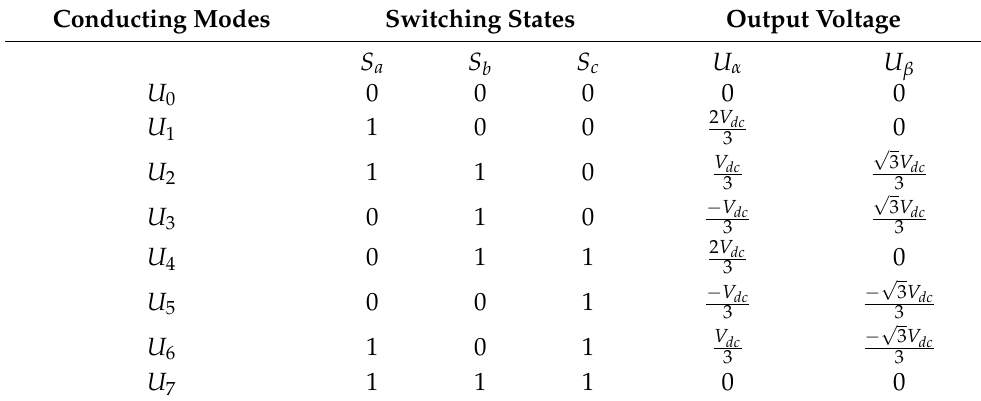
Table 1. Different switching modes and corresponding voltage vector of the voltage source